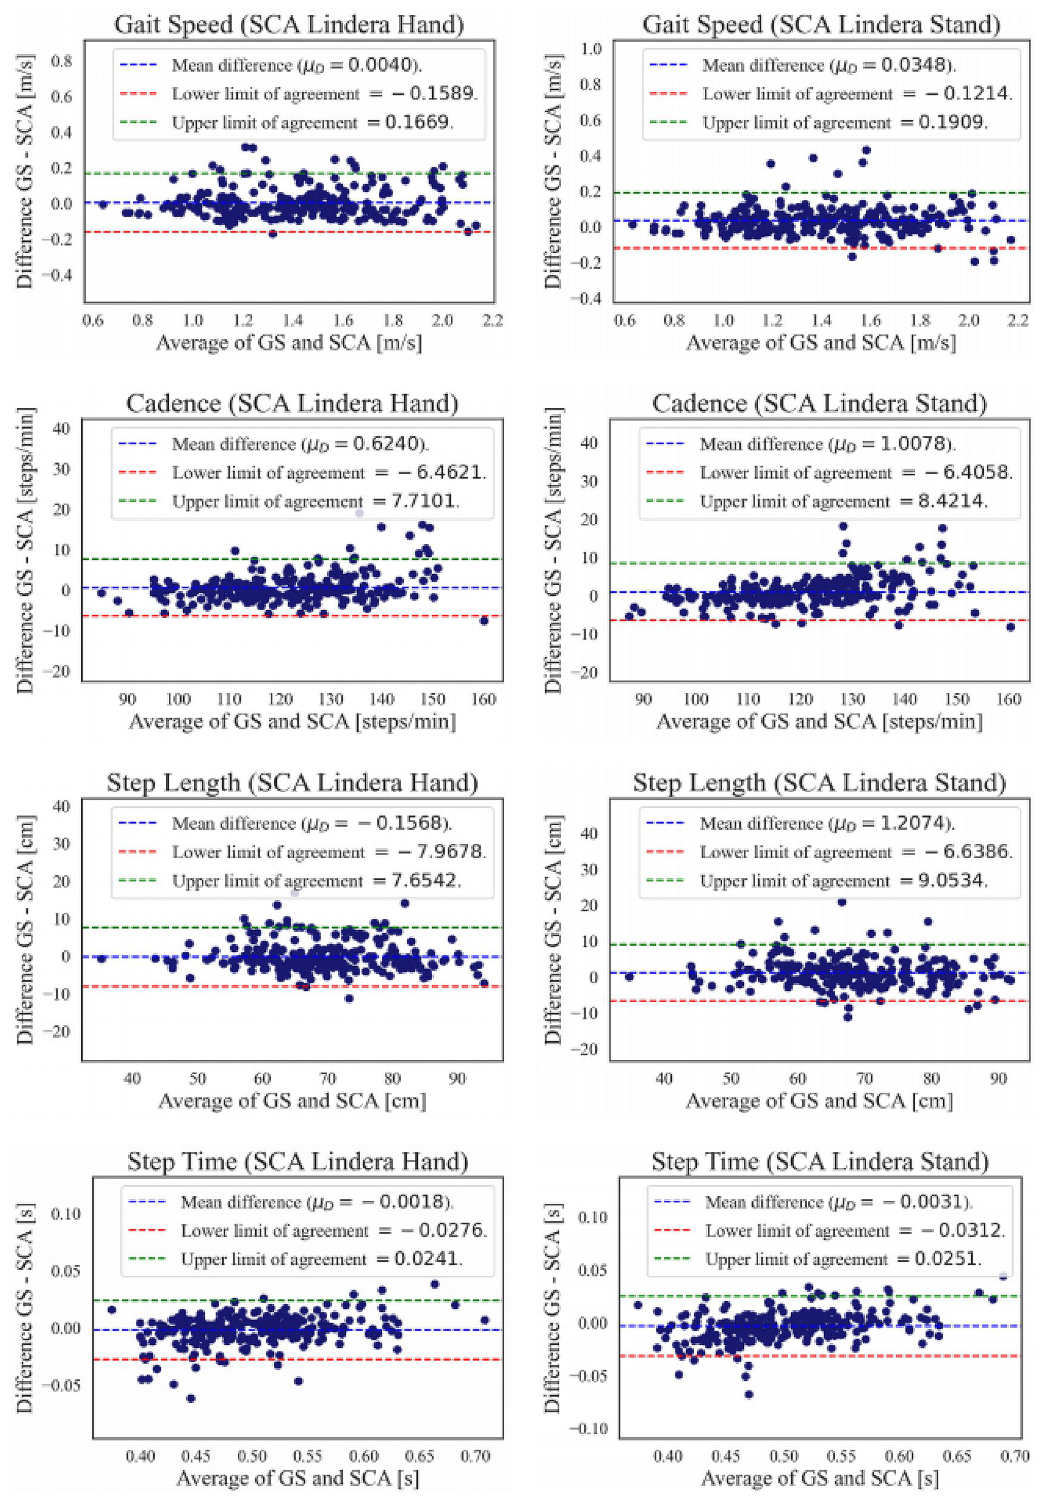
Figure 2. Bland–Altman plots for each measured gait parameter and SCA conditions (Hand and